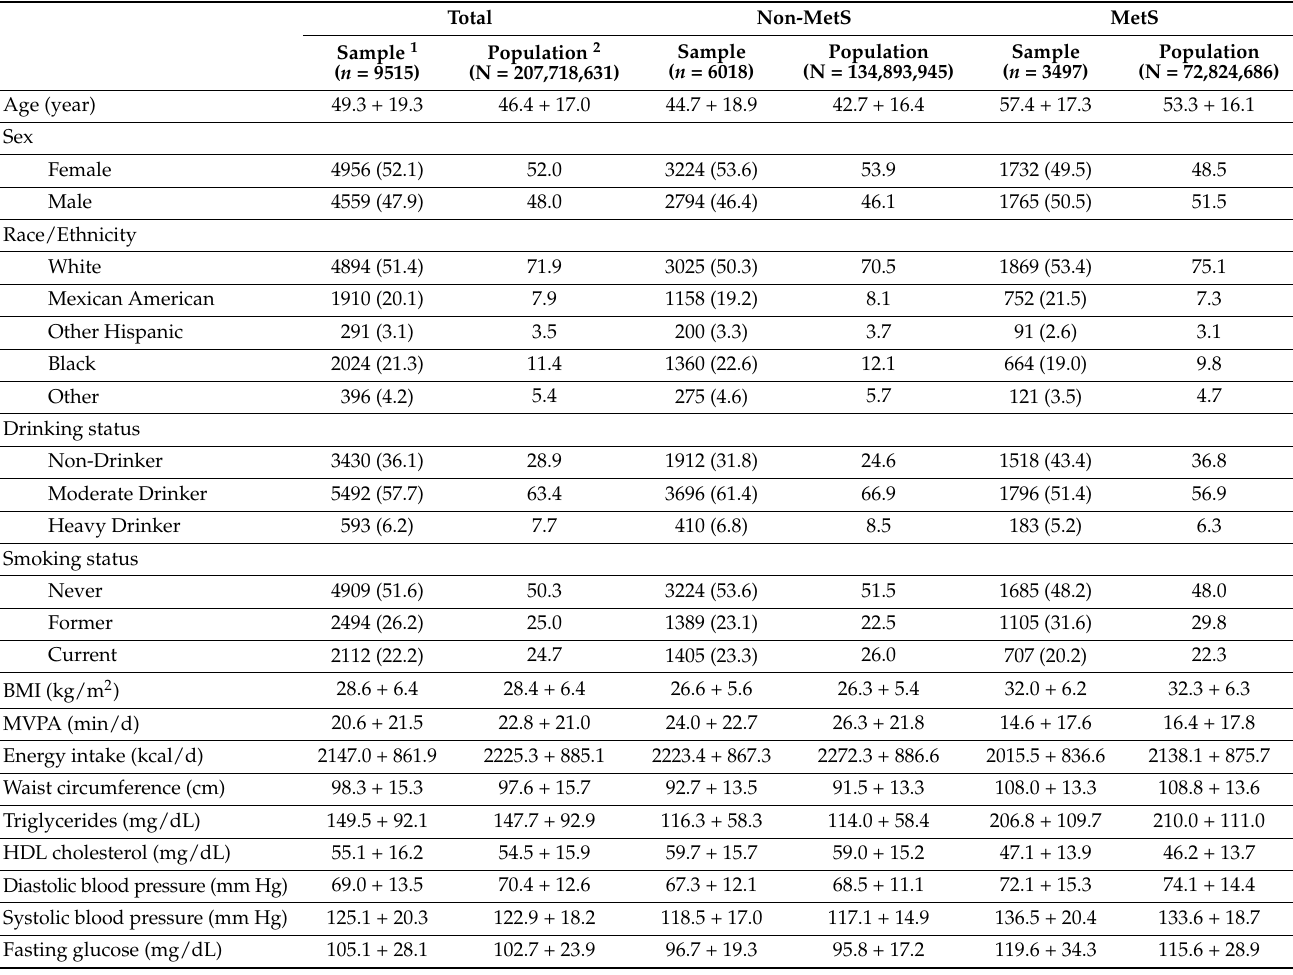
Table 1. Descriptive characteristics, NHANES